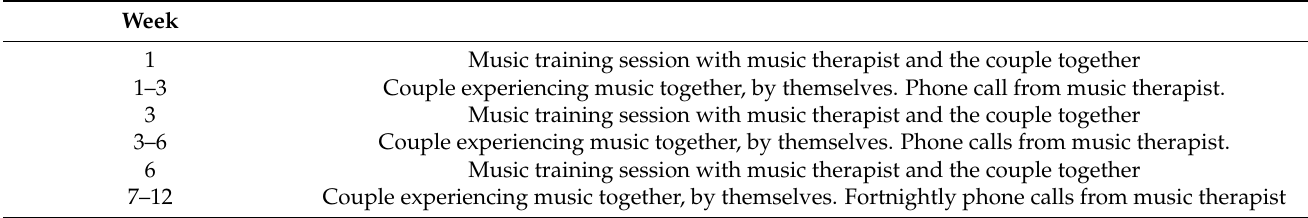
Table 2. The home-based music therapy